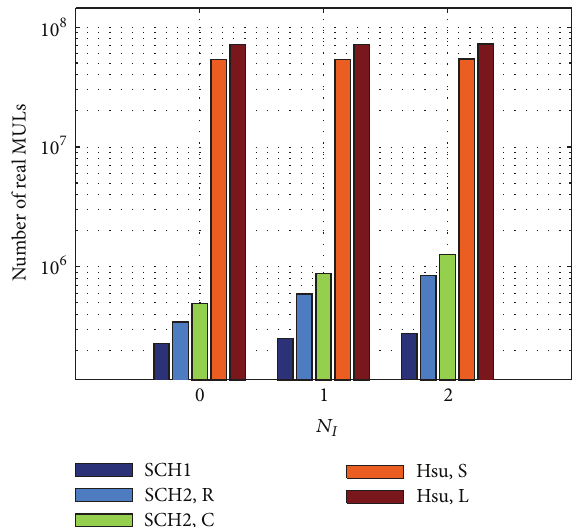
Figure 13: Number of required real MULs for different schemes as a function of 𝑁 𝐼 , 𝑁 = 256 and 𝑁 0 = 17